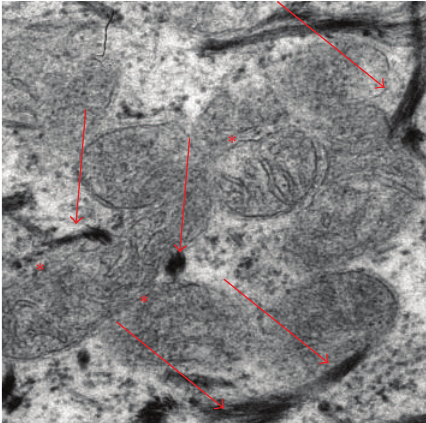
Figure 7: TEM images of AgNps (red arrows) in cyplosmasmatic space of fibroblast present in a healed skin sample treated with AgNP based Medical devices. AgNP (red arrows) are closed to the mitochondria (red ∗ ).